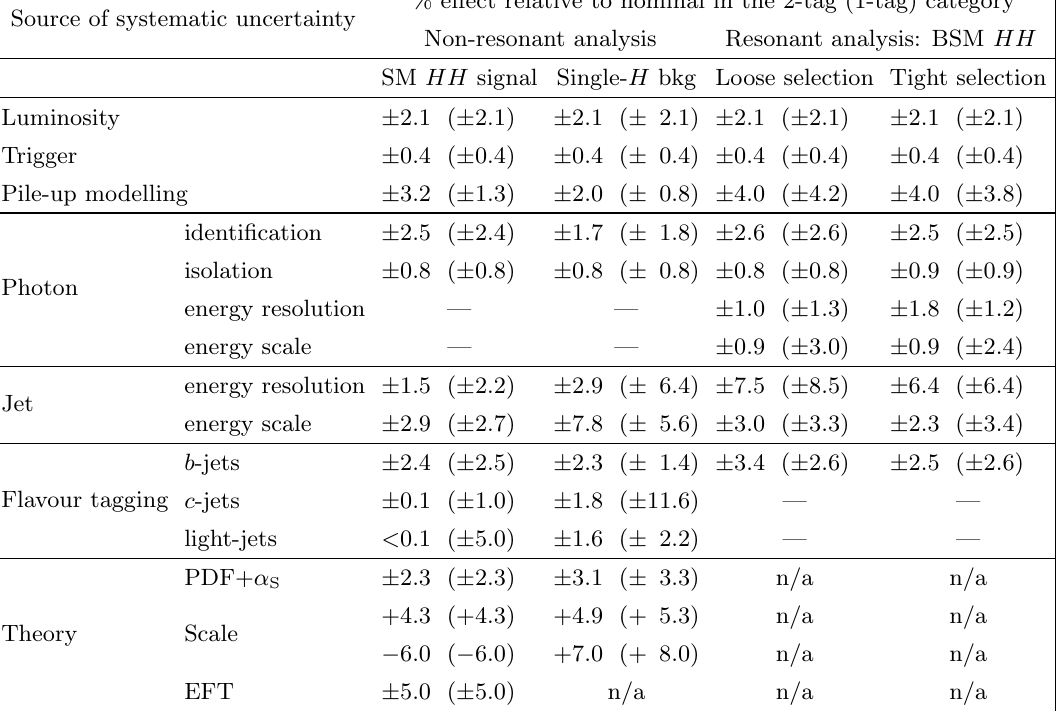
Table 2. Summary of dominant systematic uncertainties a(cid:11)ecting expected yields in the resonant and non-resonant analyses. For the non-resonant analysis, uncertainties in the Higgs boson pair signal and SM single-Higgs-boson backgrounds are presented. For the resonant analysis, uncer- tainties on the Higgs boson pair signal for the loose and tight selections are presented. Sources marked ‘|’ and other sources not listed in the table are negligible by comparison. No systematic uncertainties related to the continuum background are considered, since this is derived through a (cid:12)t to the observed data.